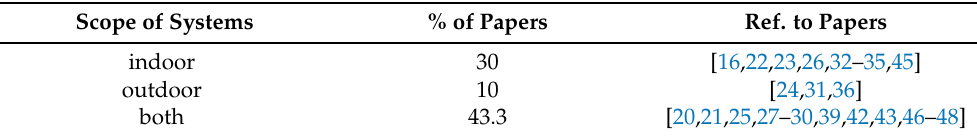
Table 7. Scope of assistive systems. Some studies do not clearly specify their targeted